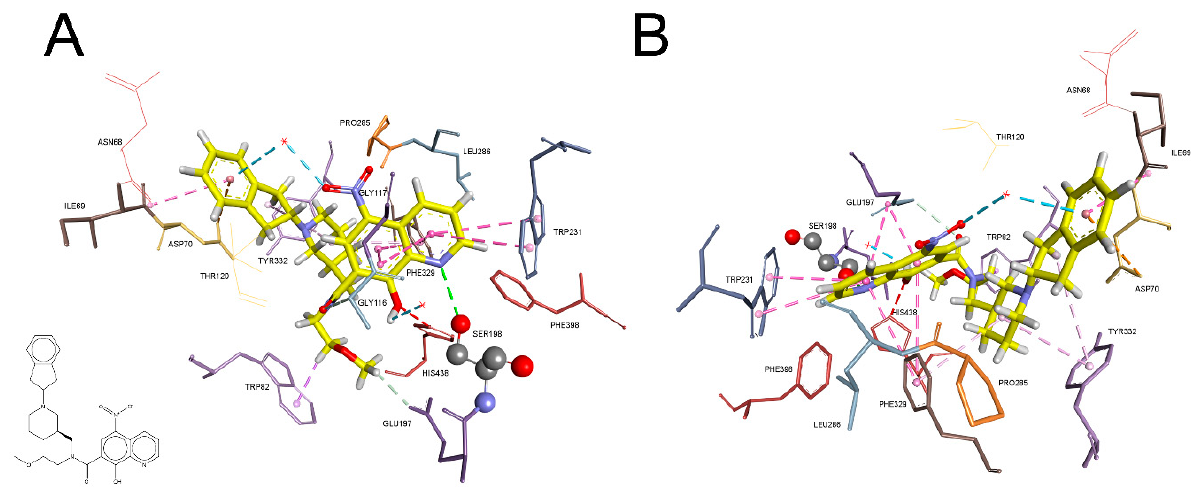
Figure 4. The crystal structure of the complex of a potent inhibitor with human BChE. N -[[(3 R )-1-(2,3-dihydro-1 H -inden-2-yl)piperidin-3-yl]methyl]-8-hydroxy- N -(2-methoxyethyl)-5-nitroquinoline-7-carboxamide (PDB ID: 4XII) [32]. Frontal view ( A ) and rotated view ( B ). Ligand carbon atoms are yellow, oxygen atoms are red and nitrogen atoms are blue. Catalytic Ser198 is represented as ball and stick. Interactions with BChE active site residues are represented as dashed lines: hydrophobic (purple or pink), hydrogen bonds (green or teal) and electrostatic (orange).